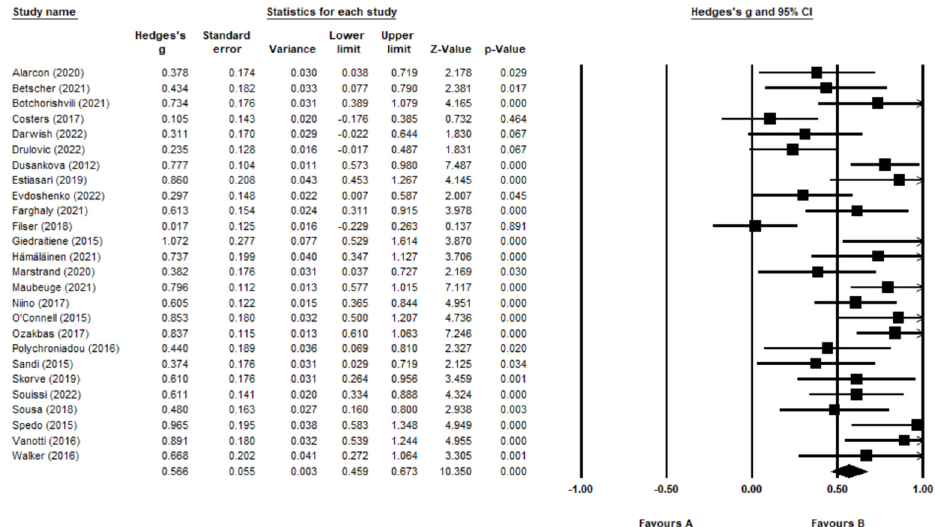
Figure 4. Forest Plot for CVLT-II. Alarc ó n et al. [46]; Betscher et al. [47]; Botchorishvili et al. [48];